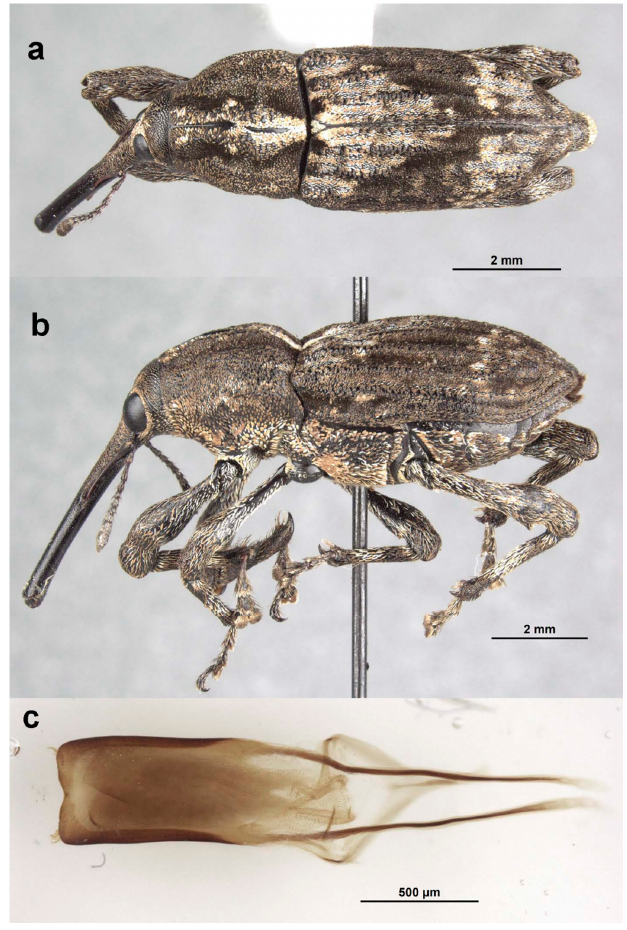
Figure 6. Ilacuris laticollis : ( a ) habitus of female, dorsal aspect; ( b ) habitus of female, lateral aspect; ( c ) aedeagus, dorsal aspect.